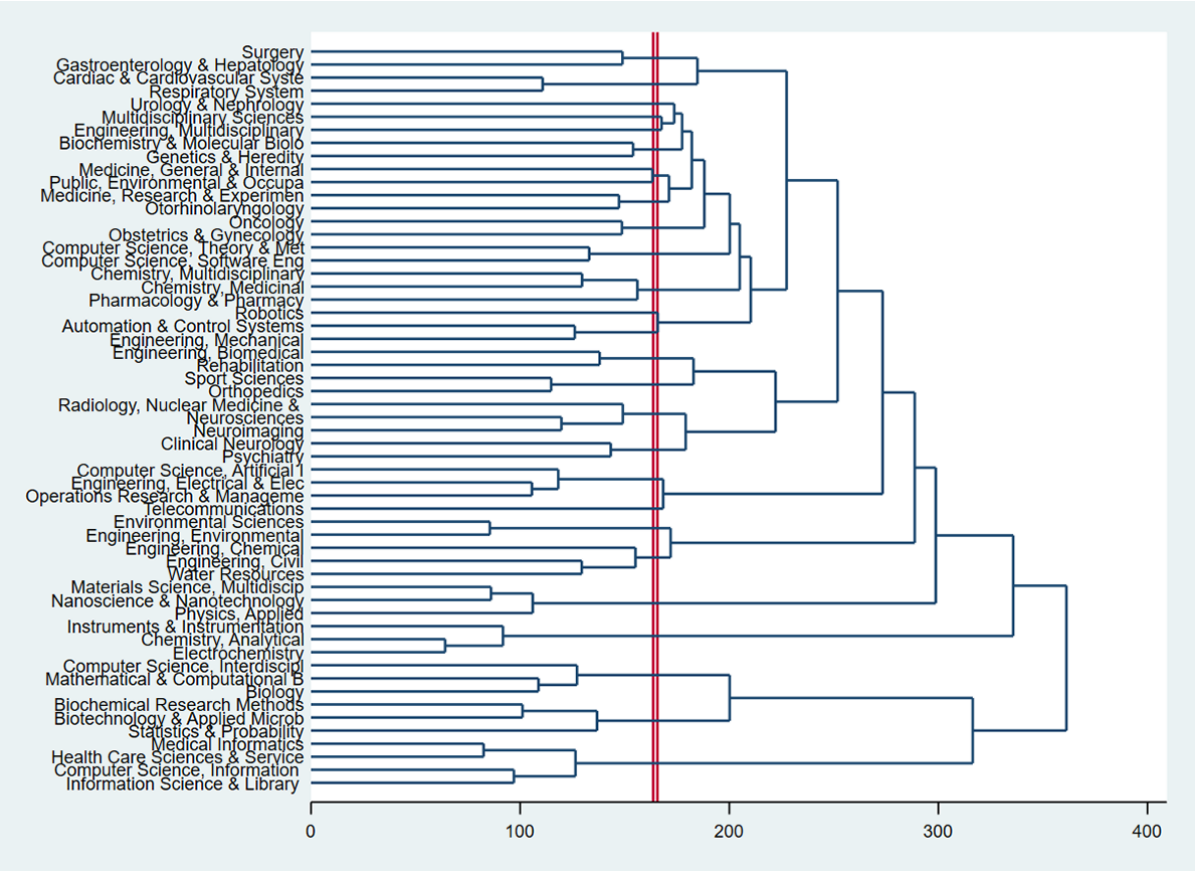
Figure 2. Dendrogram of coincidence of research areas using the Web of Science